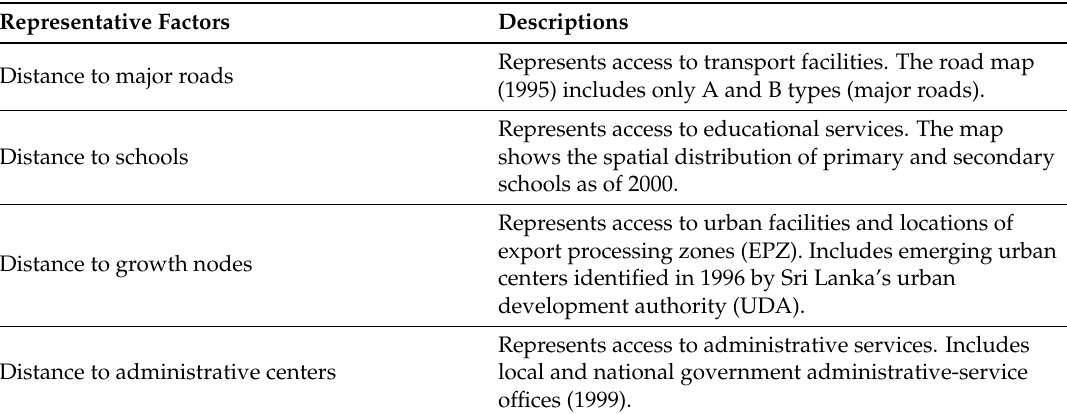
Table 1. Driving factors and their